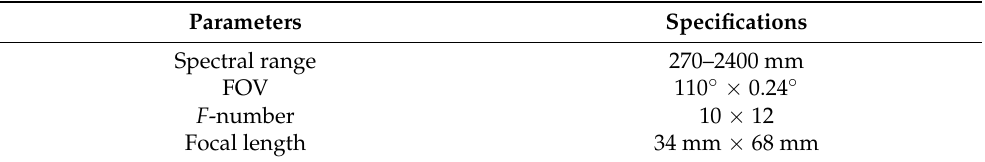
Table 1. Specifications of the UFOTAS.